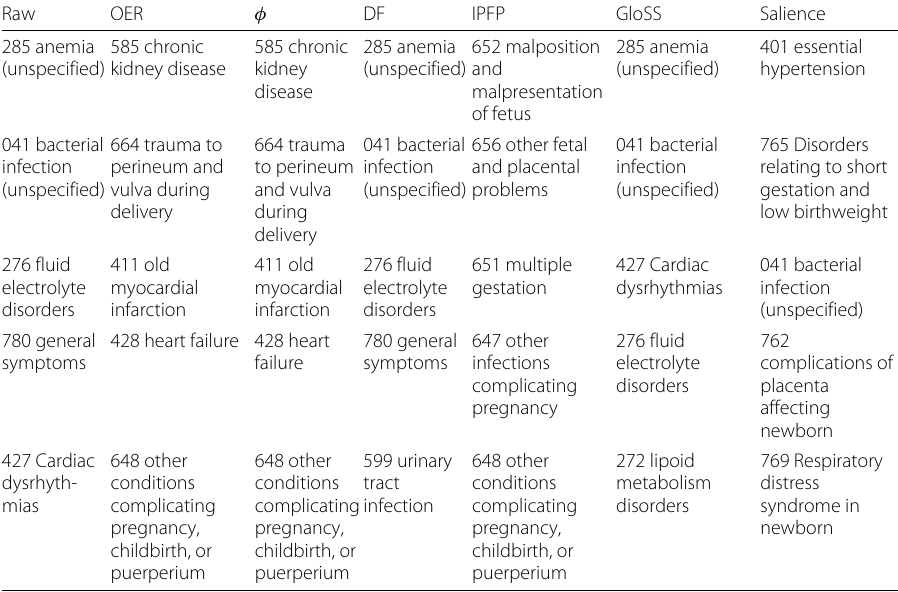
Table 12 Top 5 diseases with highest authority scores in different networks, according to the HITS